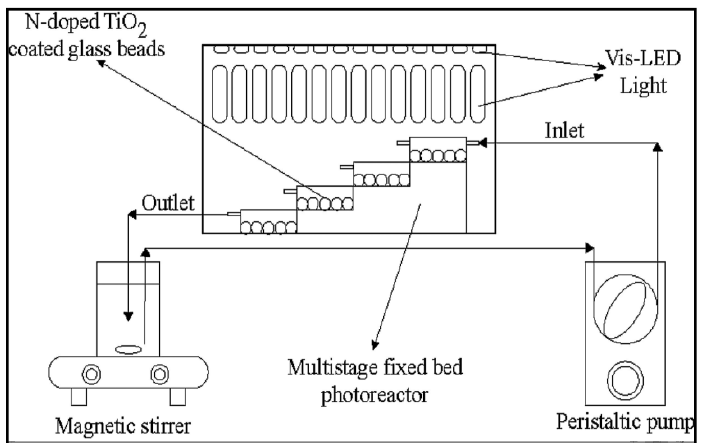
Figure 9. Multiple stage photoreactors for E. coli inactivation. Reprinted from [132], Copyright (2020), with permission from Elsevier.